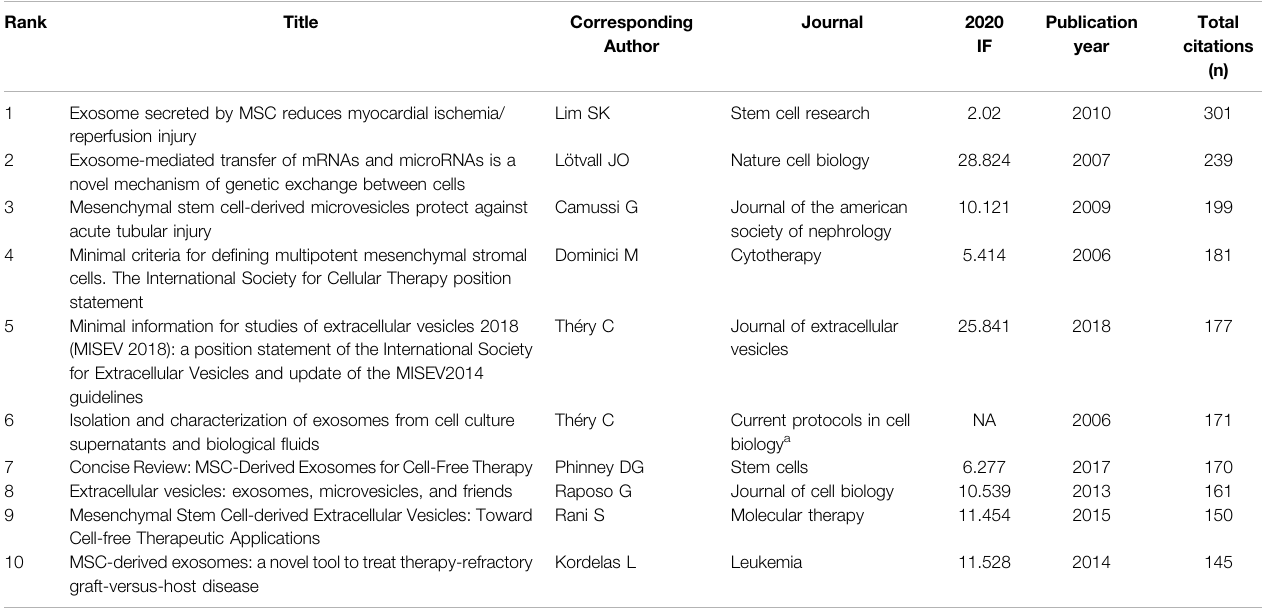
TABLE 6 | The top ten co-citation analysis of cited reference on